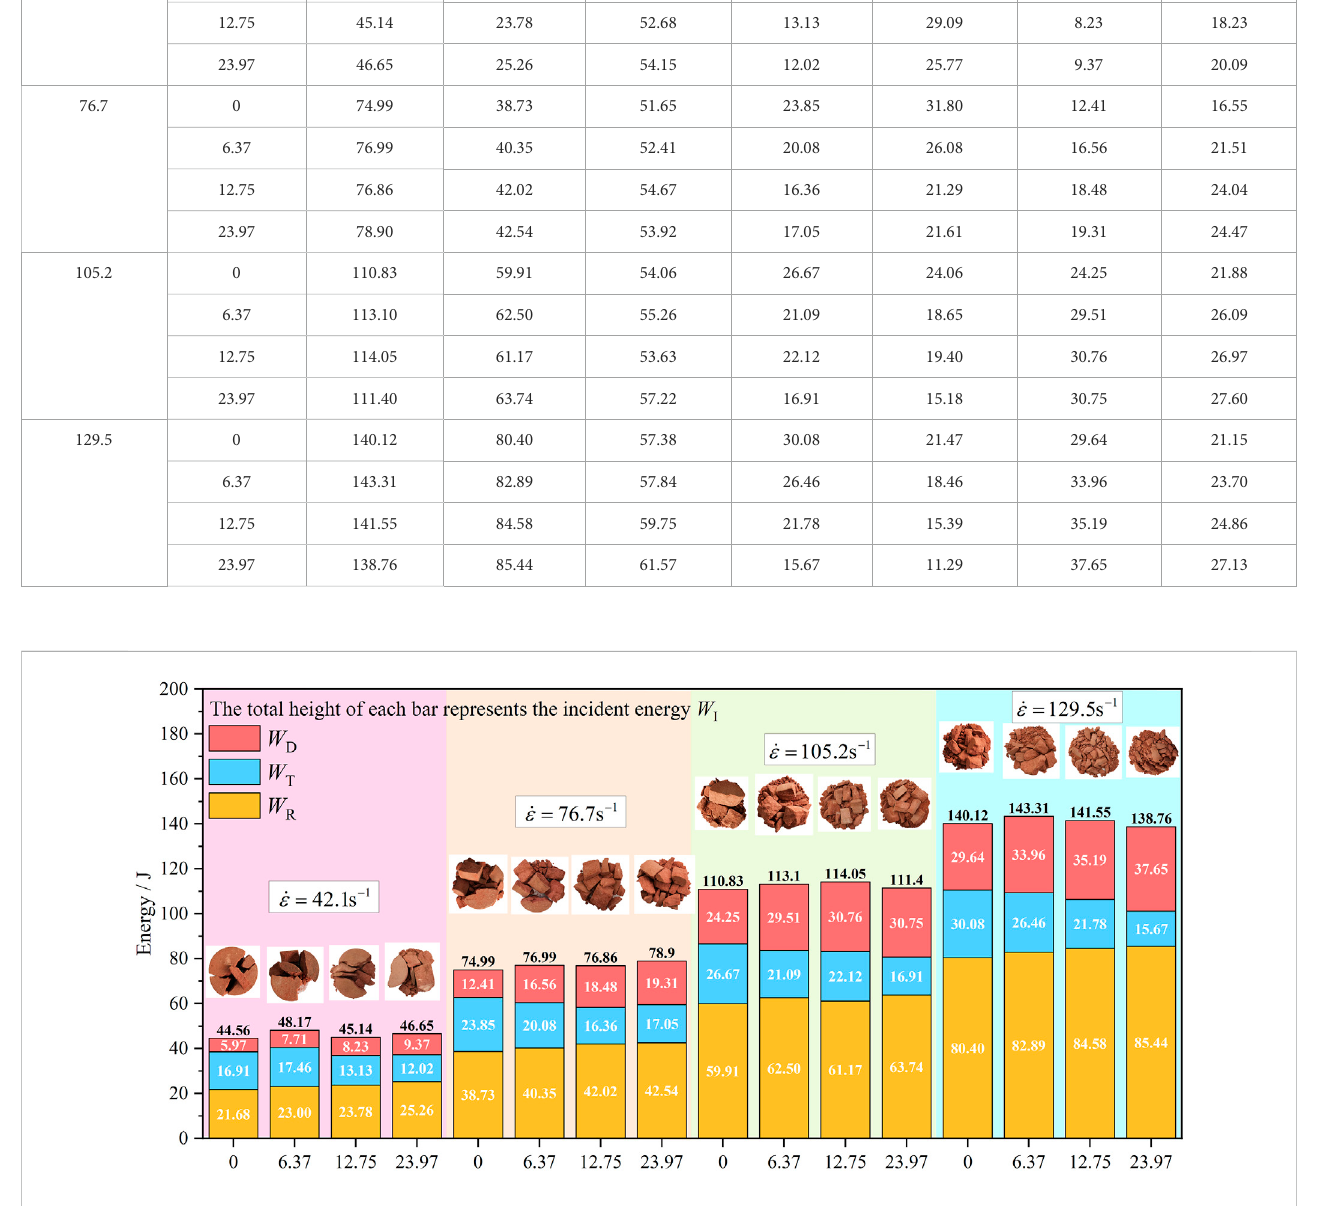
is similar to the in fl uence of the initial damage value on the dissipated energy ratio. The strain rate can effectively improve the energy utilization rate during sandstone failure process and reduce the proportion of energy lost due to transmission.